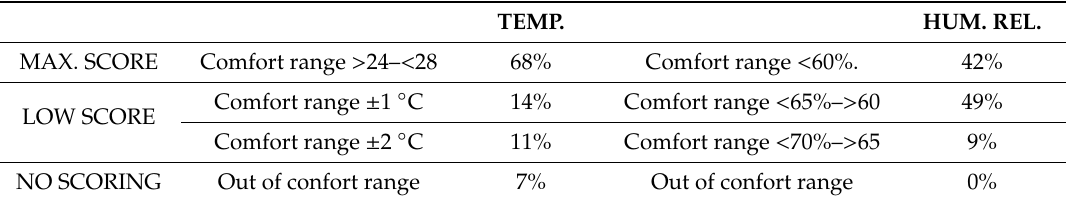
Table 6. Percentage of Hours (in scoring hours) in Comfort Range. TEMP. HUM. REL.